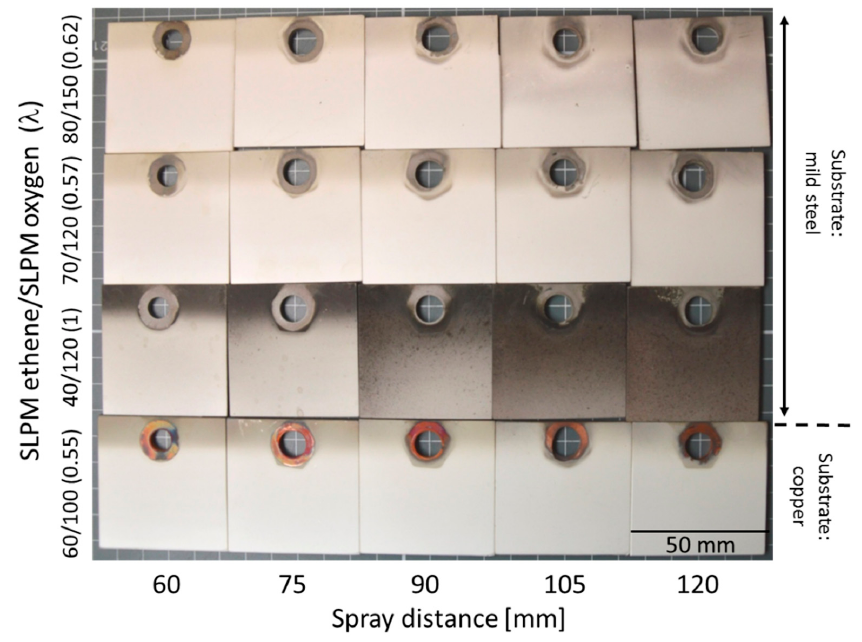
Figure 15. Color scheme of silver coating surfaces sprayed at different parameter sets worked out in a pre-study. Size of each sample is 50 × 50 mm.